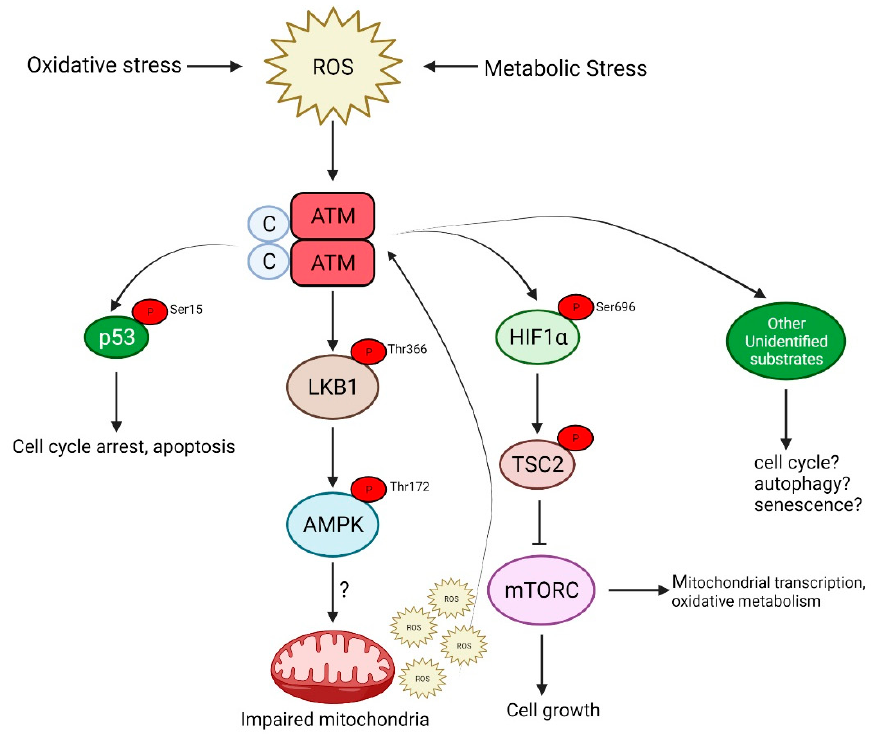
Figure 2. ATM is activated in response to oxidative stress caused by the increased production of reactive oxygen species (ROS). This activation is independent of the DNA damage signaling pathway and signals via AMPK, p53 or mTORC, which may culminate in either of the following: cell cycle arrest, autophagy and senescence or even apoptosis in the case of severe DNA damage.